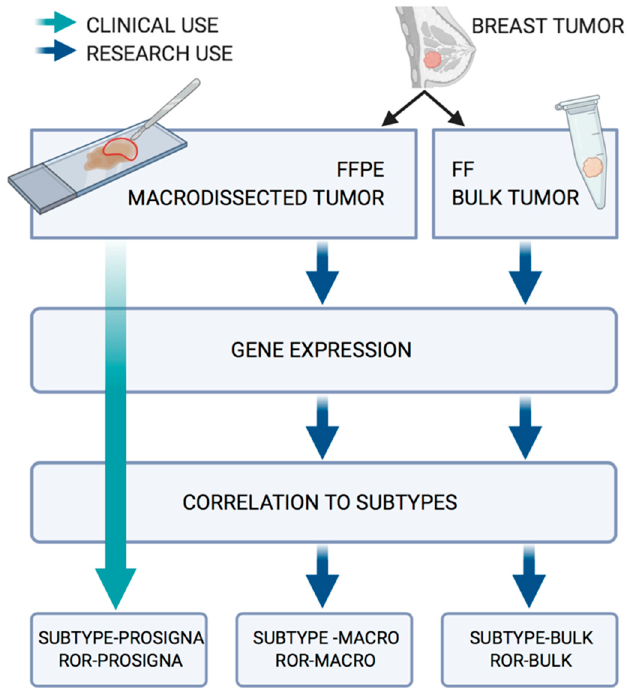
Figure 1. Workflow for the analysis of the 94 paired FFPE/FF